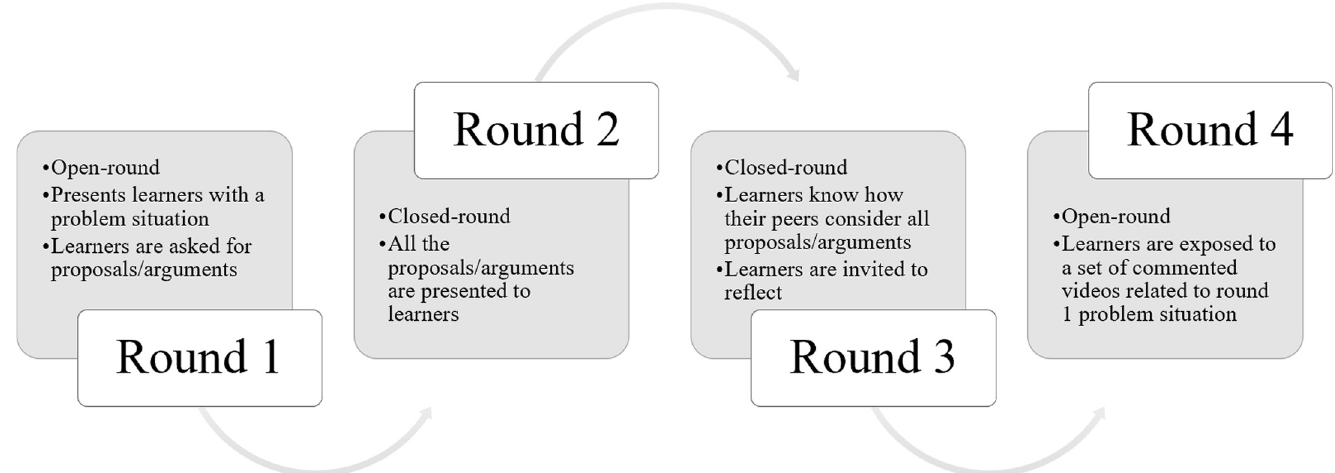
Fig 1. Schematic presentation of the design of the ANIPHI template. The figure details the specific round requests and challenges.